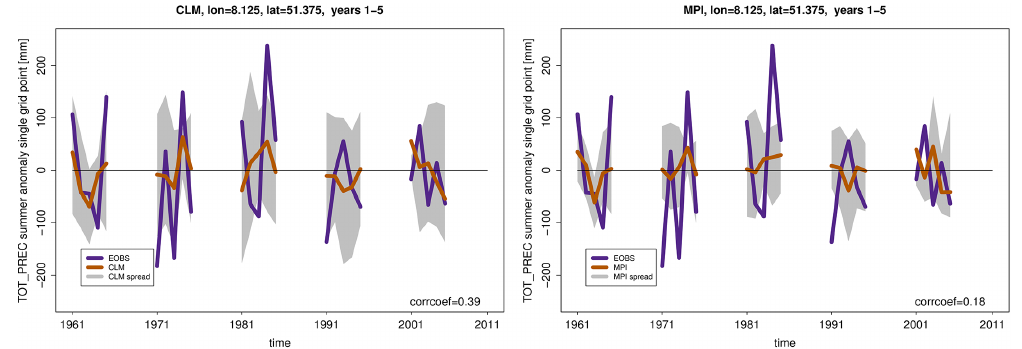
Figure 3. Left: Summer half-year precipitation sums of E-OBS (lilac) and CCLM ensemble mean (orange) at a location in Germany for lead years 1–5. The correlation coefficient is 0 . 39. The grey shaded area depicts the CCLM ensemble spread, i.e. the standard deviation over the ensemble. Right: Same location but for MPI-ESM-LR ensemble mean (orange). The correlation coefficient is 0 .